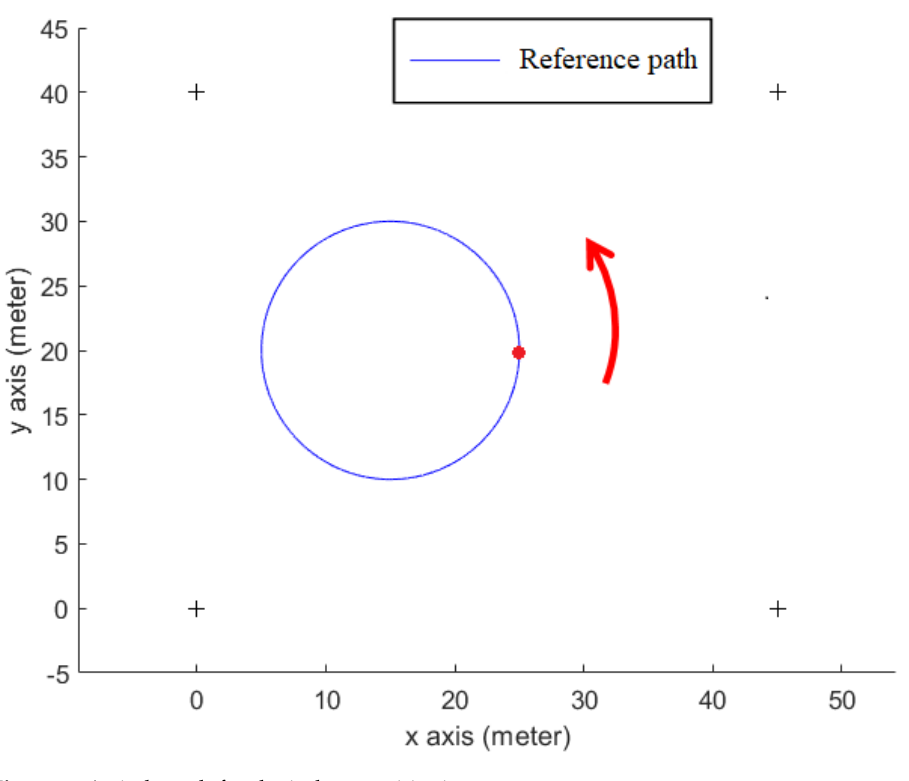
Figure 7. A circle path for the indoor positioning test.